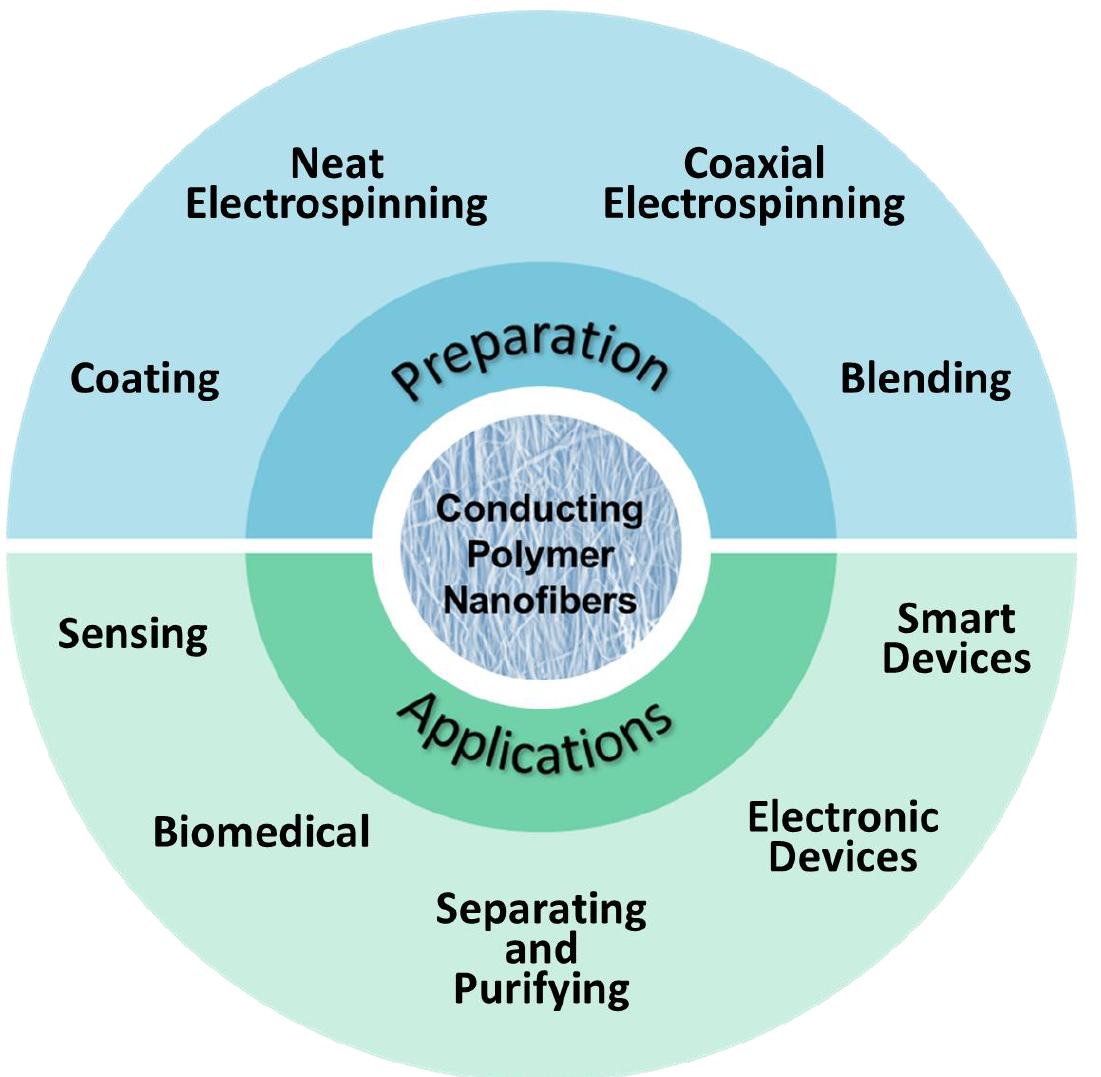
Figure 2. This review article summarizes methods of preparation of CP nanofibers and their appli- cation in several areas.